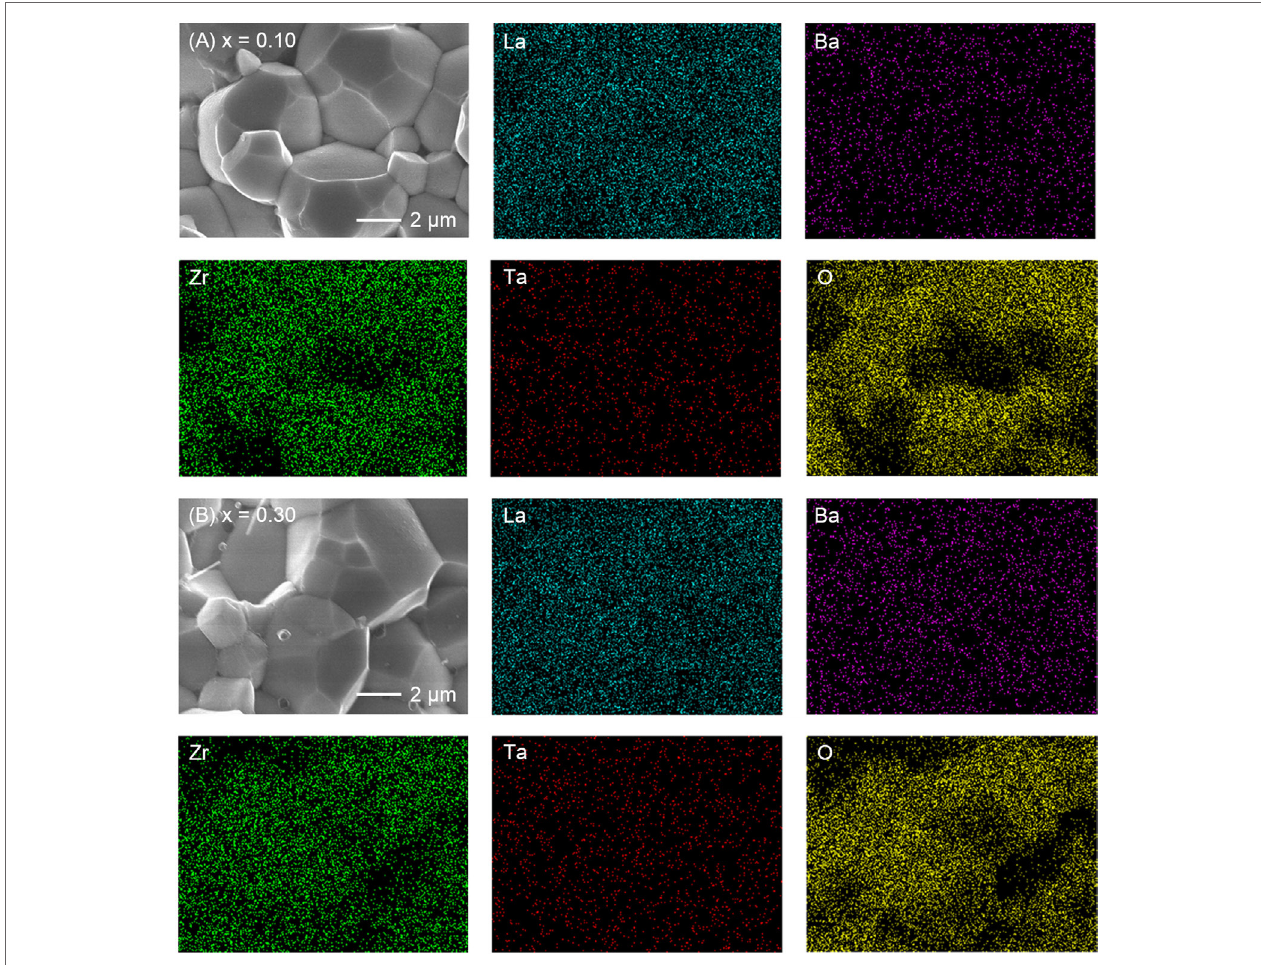
FigUre 5 | seM images and corresponding elementary mapping for la, Ba, Zr, Ta, and O for llBZT with (a) x = 0.10 and (B) x = 0.30